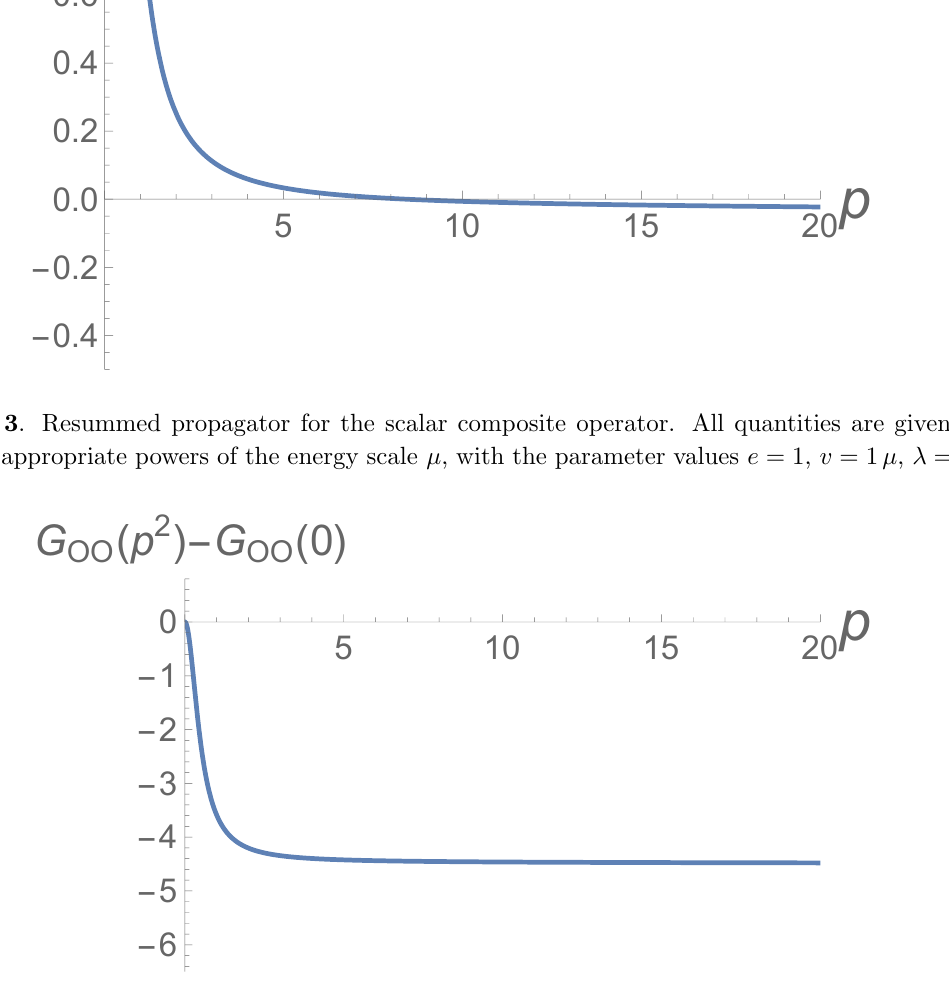
Figure 4 . The resummed propagator with a single subtraction. All quantities are given in units of appropriate powers of the energy scale (cid:22) , with the parameter values e = 1, v = 1 (cid:22) , (cid:21) = 1